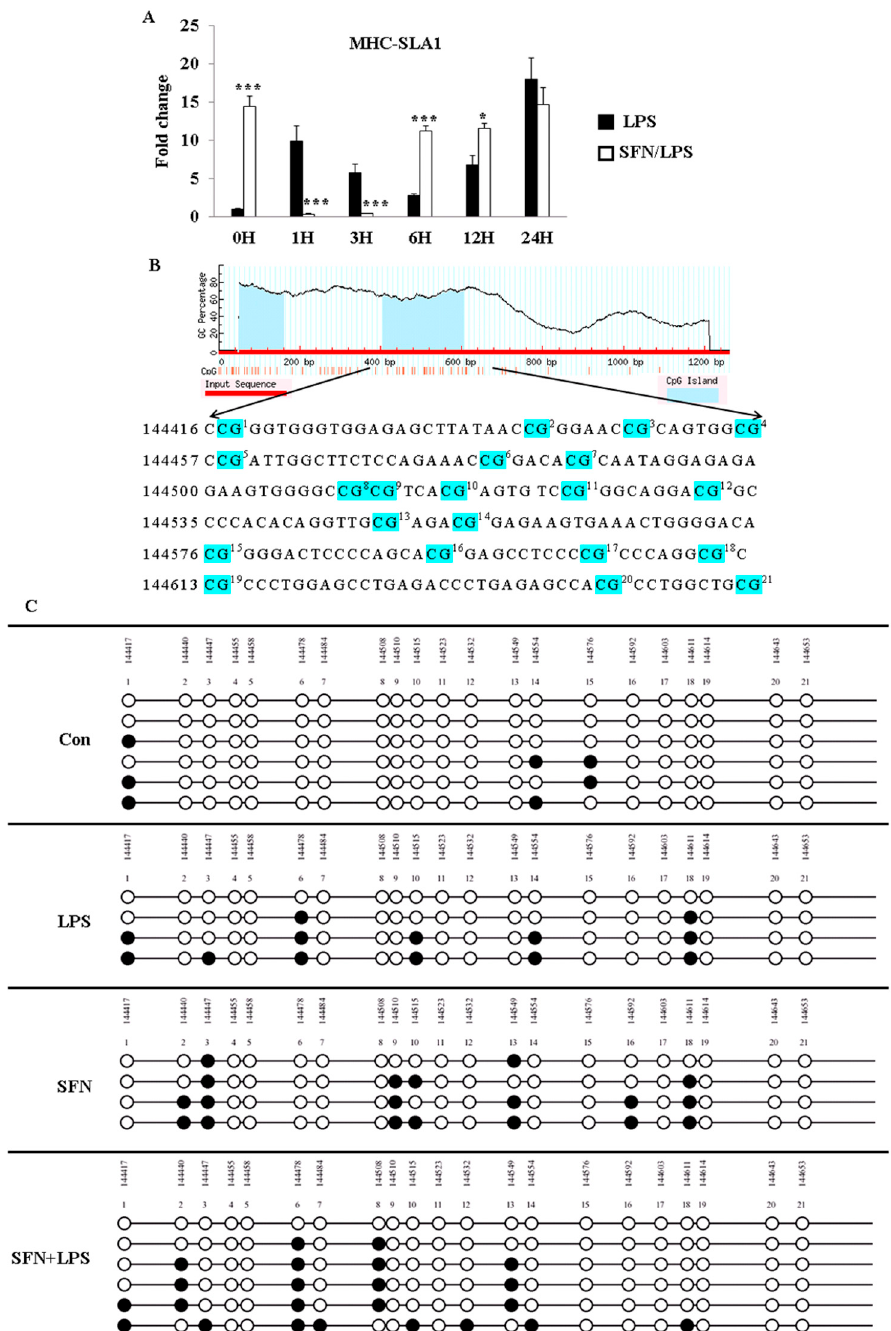
were randomly picked for sequencing with M13 primers. The sequencing results were visualized using QUMA software. White plots correspond to unmethylated CpGs, and black plots corre ‐ spond to methylated CpGs.